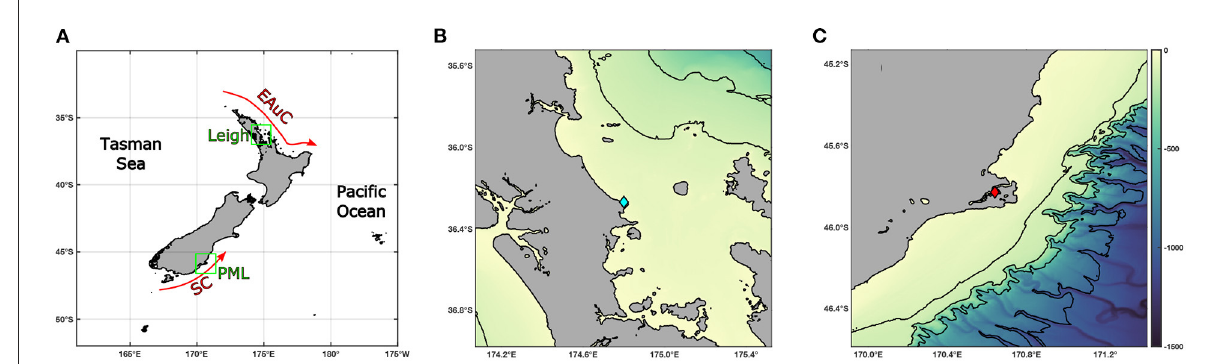
FIGURE1 Map of New Zealand (A) and the two study sites (B,C) with local bathymetry displayed. The two study sites around Leigh Marine Laboratory (Leigh) and Portobello Marine Laboratory (PML) are outlined in green in (A) . Also displayed in red are the East Auckland Current (EAuC) and Southland Current (SC). The coastal station at Leigh (B) and PML (C) are identified by a blue and red diamond, respectively. Contours are displayed in (B,C) for the 100, 200, 500, and 1,000 m